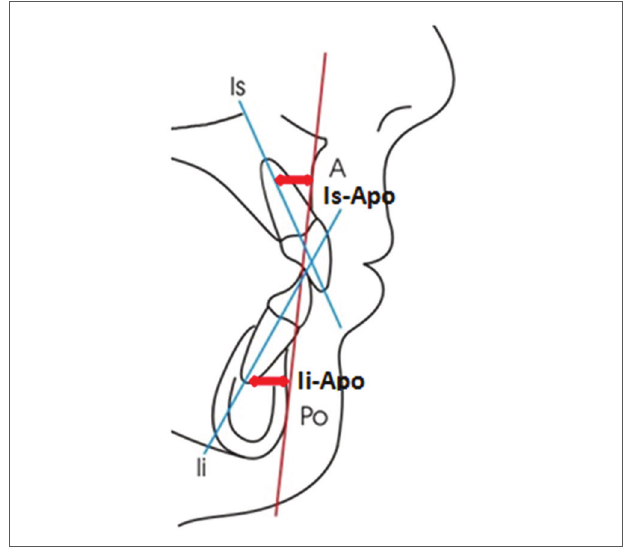
Figure 1. Linear measures which analyzes the upper (Is-Apo) and lower (Ii-Apo) incisor positioning in regards to the Apo reference